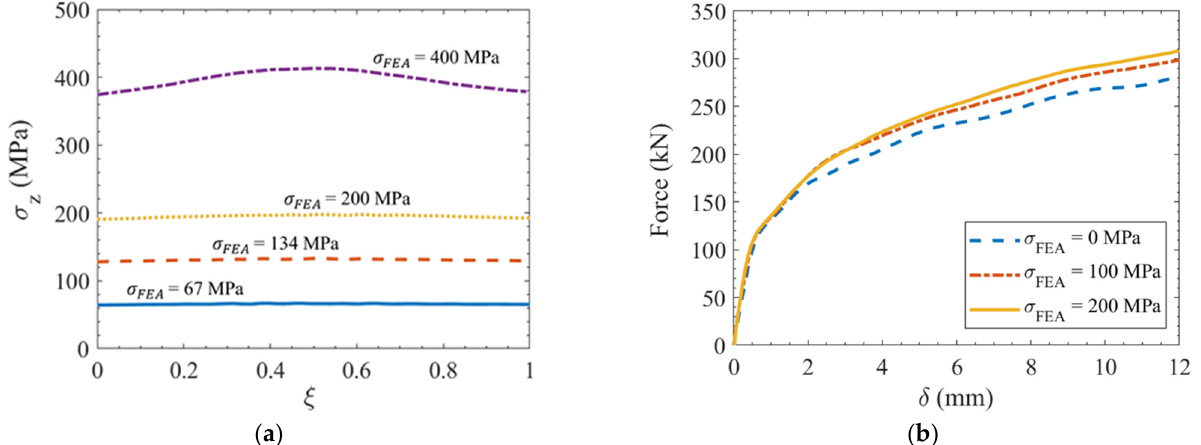
Figure 6. ( a ) Stress distribution through rivet shank at various pre-load levels and ( b ) effect of pre-load on force vs. displacement of rivet joint case SN-2.